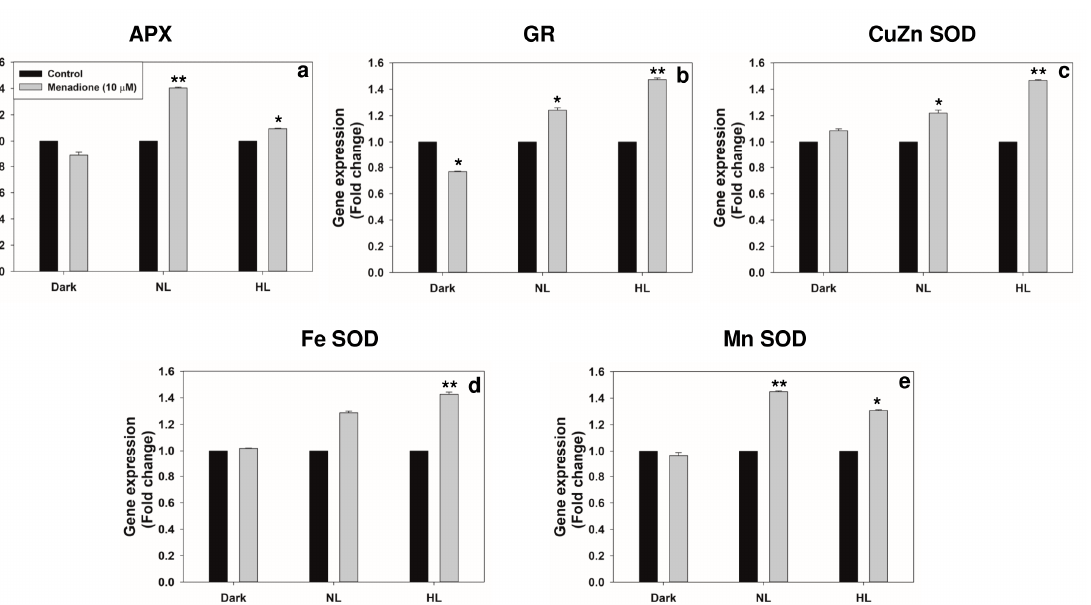
Figure 4. The activities of typical antioxidant enzymes superoxide dismutase, SOD ( a ), glutathione reductase, GR ( b ), ascorbate peroxidase, APX ( c ) in leaf extracts on treatment with menadione in normal (NL) or high light (HL). Each data point is the average of three replicates, and error bars represent ±SE. Asterisks indicate the significance of MD effect com- pared to the respective control. * p < 0.05 ; ** p < 0.001. 2.3. Modulation of Photorespiratory Enzymes in Peroxisomes and Chloroplasts by MD and/or High Light We examined the transcripts and protein levels of GO, CAT, HPR, GK, and PGLP, in the leaf extracts. When pea leaf discs were treated with MD, the transcripts of enzymes, such as GO, CAT, and HPR increased, particularly in HL (Figure 5). Similarly, the Western blots revealed that their protein levels also increased in HL and MD treatments (Figure 6).